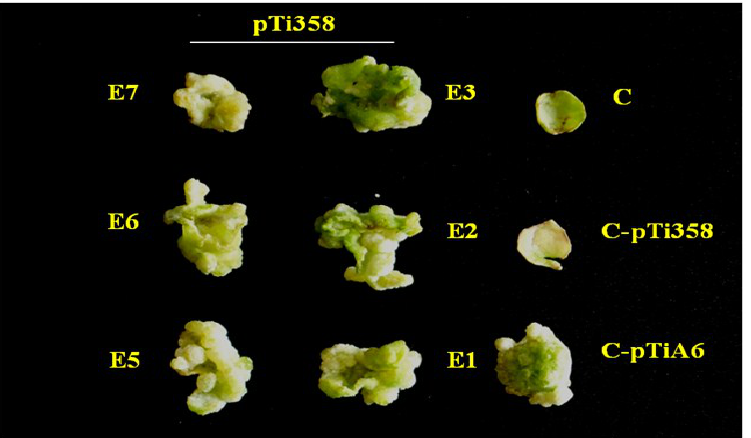
Figure 3. Functional complementation analysis of virE2 mutation in the Agrobacterium tumefaciens strain A348mx358 in leaf discs of virE2 transgenic plants grown on MS medium without hormones. A. tumefaciens A348mx358 which harbors pTi358 with virE2 mutation [30] was used to infect the leaf discs of untransformed N. benthamiana control plants (C-pTi358) and the virE2 transgenic plants (E1-E7). Untransformed control leaf discs infected with A. tumefaciens (pTiA6) (C-pTiA6) was used as the positive control. C: untransformed, uninfected N. benthamiana leaf